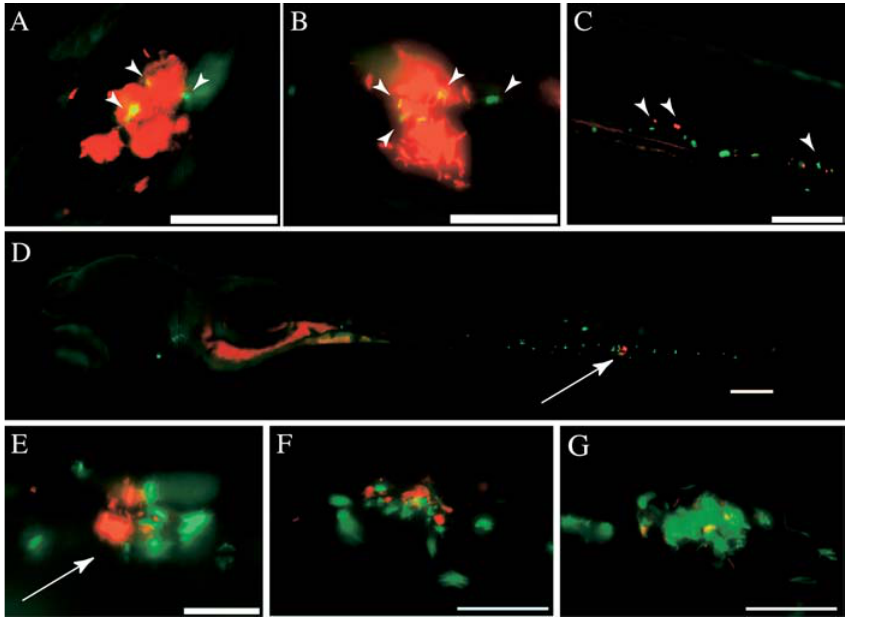
Figure 6. Superinfection with WT Bacteria Rescues D RD1 Aggregation Defect (A and B) Embryos with aggregates at 3d postinfection with 85 CFU red-fluores- cent WT bacteria are shown 4 h after superinfection with green-fluorescent strains of either D RD1 (134 CFU) (A) or WT (169 CFU) (B) bacteria. Superinfect- ing strains were injected at sites distant from the aggregates, and pictures were takenoutsideofinjectionregions.Arrow- headsindicatemacrophagesinfectedwith superinfecting strain. Scale bar, 100 l m. (C) Embryo infected with 171 CFU green-fluorescent D RD1 for 4 d shown 4 h post-superinfection with 364 CFU of red-fluorescent D RD1. Arrowheads point to macrophages infected with each of the bacterial strains. Scale bar, 200 l m. (D) Embryo infected with 171 CFU green-fluorescent D RD1 for 4 d shown 4 h after superinfection with 363 CFU of red-fluorescent WT bacteria. Arrow points to macrophage aggregate. Scale gregate (arrow) in (D) showing green fluorescent D RD1 and red fluorescent WT bacteria. Arrowhead points to WT- infected macrophage outside the aggre- gate. Scale bar, 50 l m.